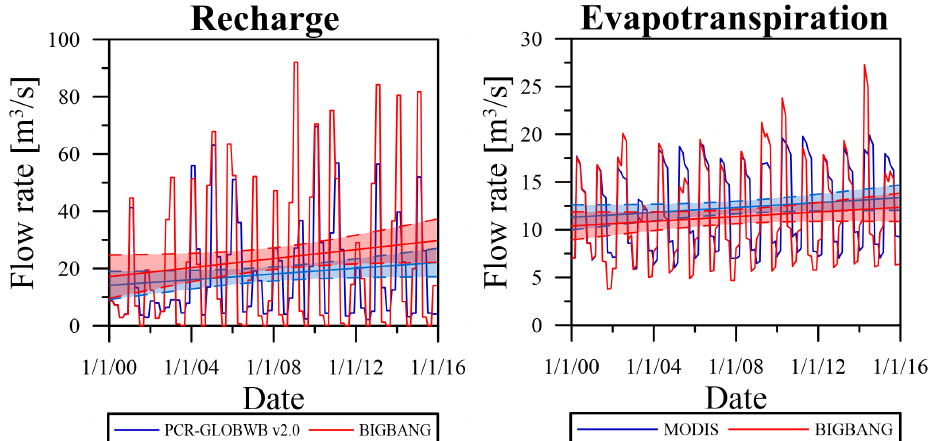
Figure 7. Left panel : comparison between the recharge rates obtained by PCR-GLOBWB v2.0 and BIGBANG, with their linear trends (solid lines); Right panel : comparison between the evapotran- spiration rates obtain by MODIS products and BIGBANG, with their linear trends (solid lines). The coloured areas between the dashed lines represent the 95% confidence interval.